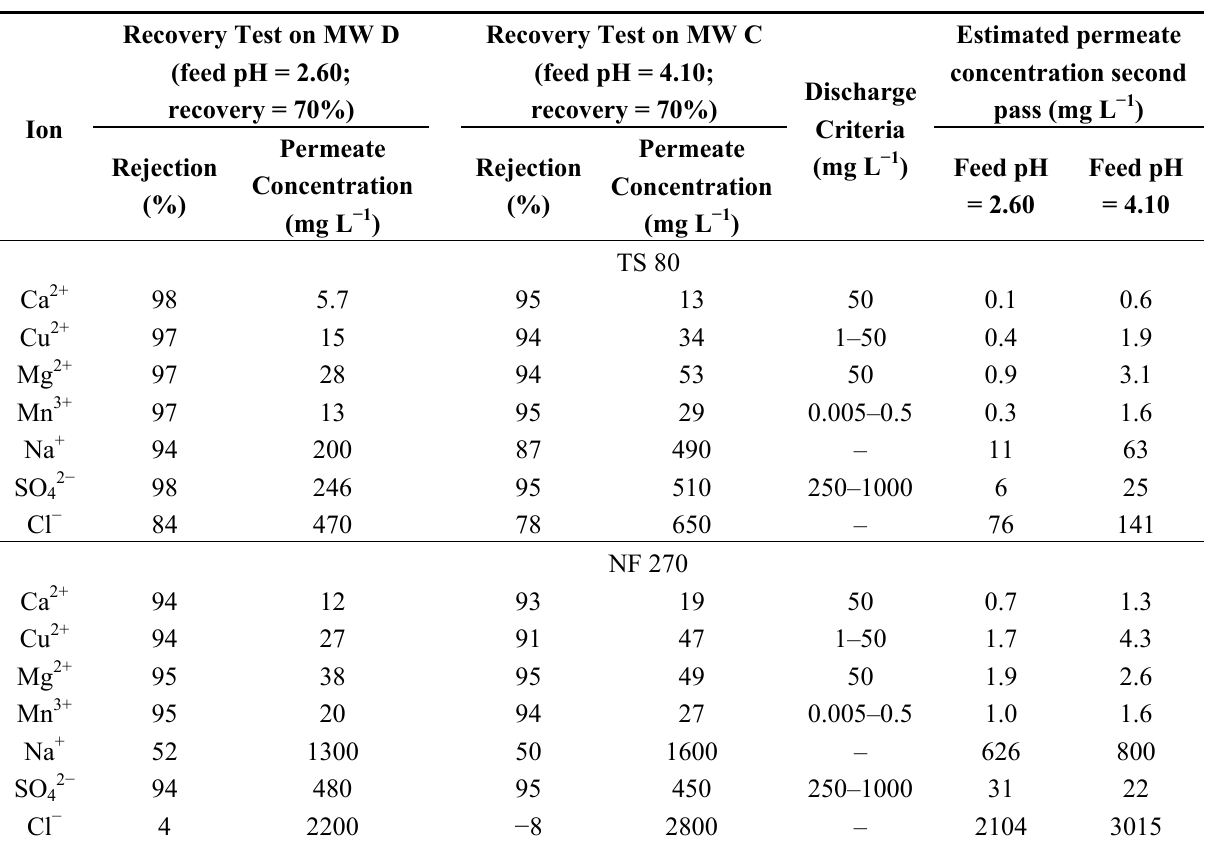
Table 4. The results of the Recovery Tests. Tested feed solution: MW D at pH 2.60 and MW C at pH 4.10. Tested membrane: NF 270 and TS